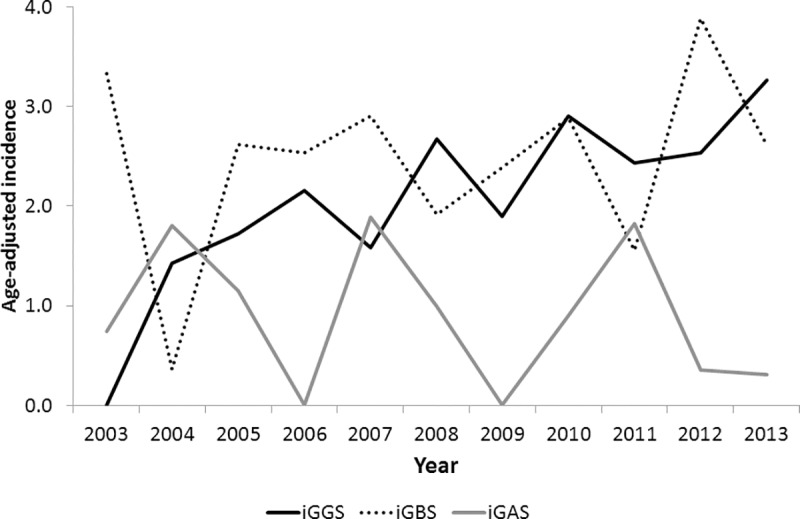
The incidence of invasive streptococcal infections per 100,000 inhabitants (2003–2013).